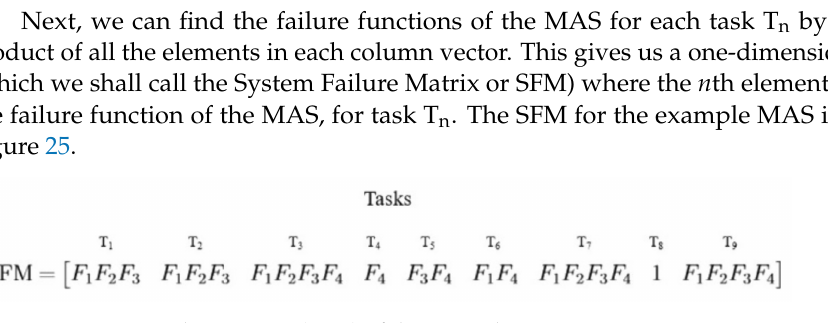
Figure 25. System Failure Matrix (SFM) of the example MAS.